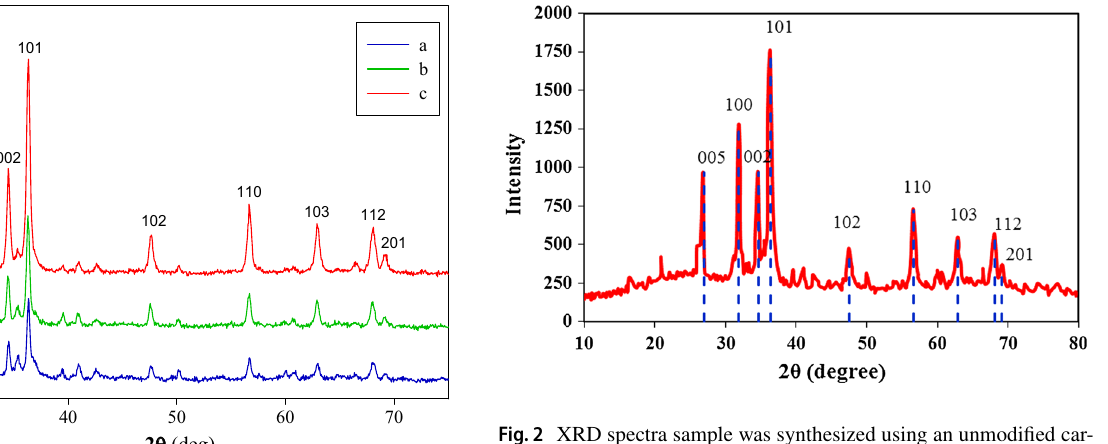
Table 1 Comparing of XRD samples (a), (b) and (c) and sample synthesized using unmodified carbon with standard sample